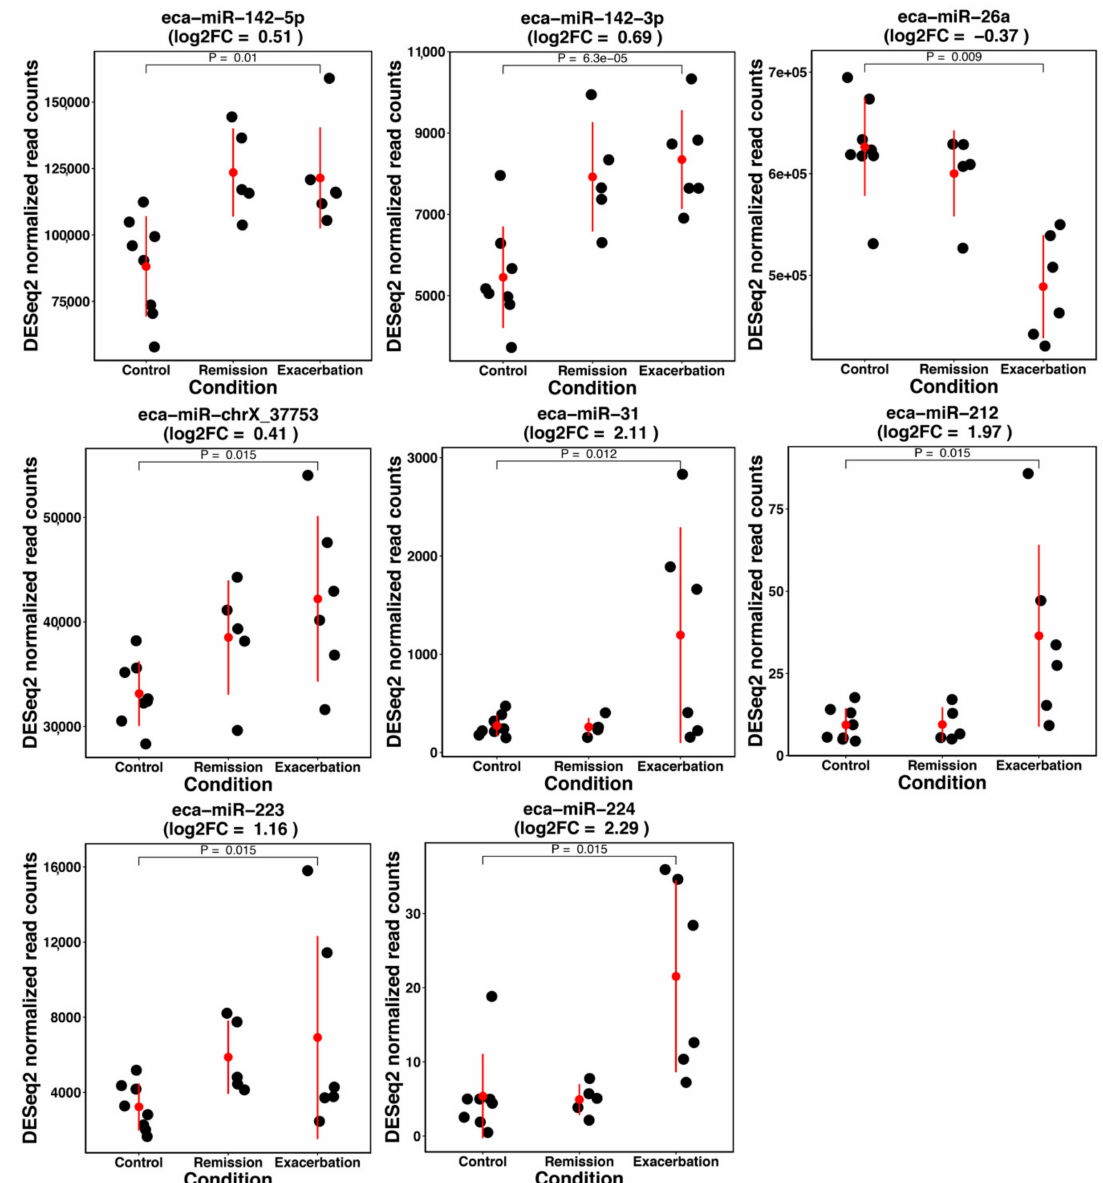
Figure A5. Obtained normalized read counts for all di ff erentially expressed miRNAs for the contrast exacerbation vs. controls. The red dot indicates the mean expression value and the red bars span the range of plus and minus one standard deviation. Adjusted p -values are listed for the contrast of